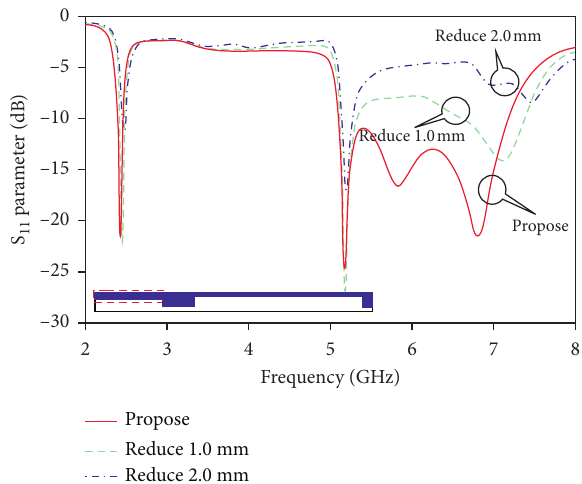
Figure 6: Simulated S 11 with different lengths of couple-fed left arm of